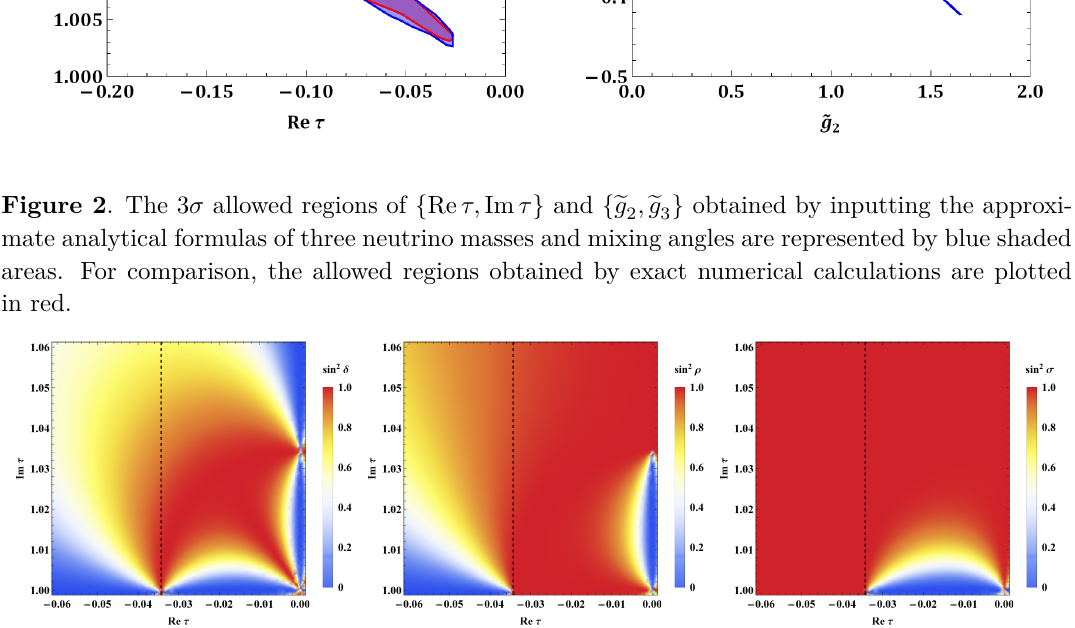
= 1 . 456 and g e 2